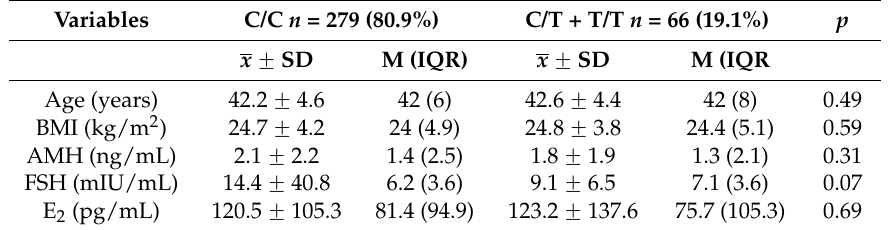
Table 5. The genotypes of the AMHR2 polymorphism (rs11170547) vs. age, BMI, hormone levels and ovarian parameters in the follicular phase in healthy late reproductive stage women ( n = 345). Variables C/C n = 279